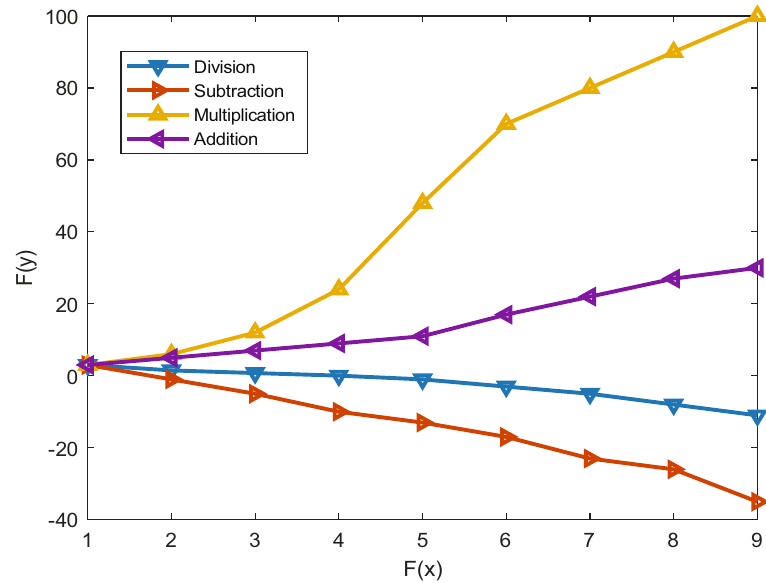
Figure 2: The McKay behavior of the arithmetic